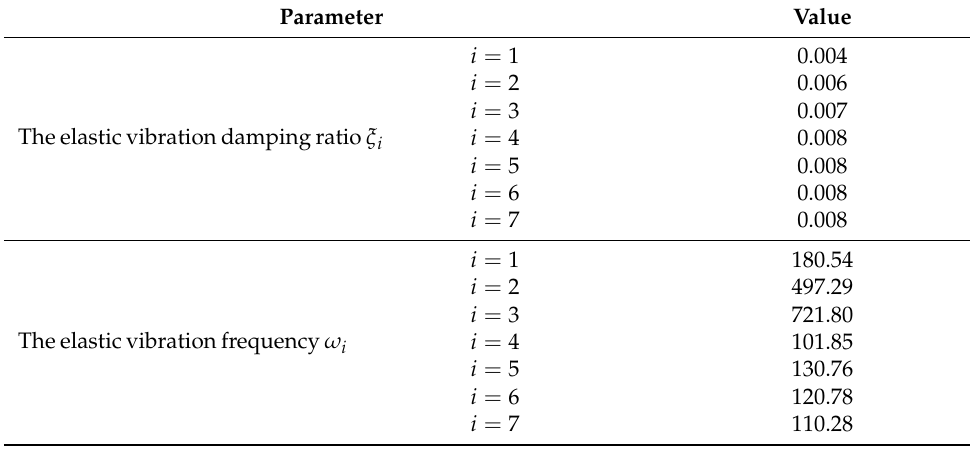
Table 2. Simulation parameters of elastic vibration.